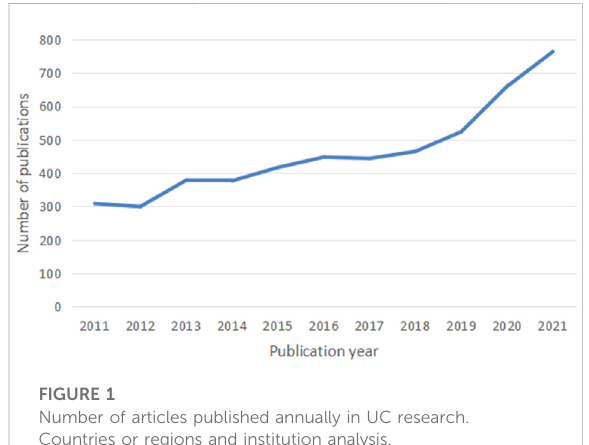
Figure 1. In terms of volume growth, the overall trend has kept increasing from 2011 to 2021 and roughly falls into three